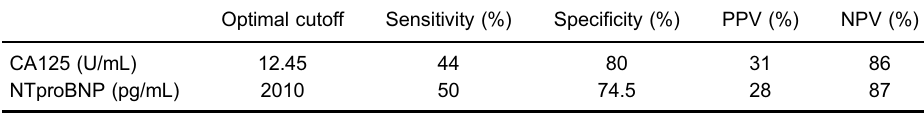
Table 3. Performance of CA125 and NTproBNP in predicting pulmonary congestion. Optimal cutoff Sensitivity (%)